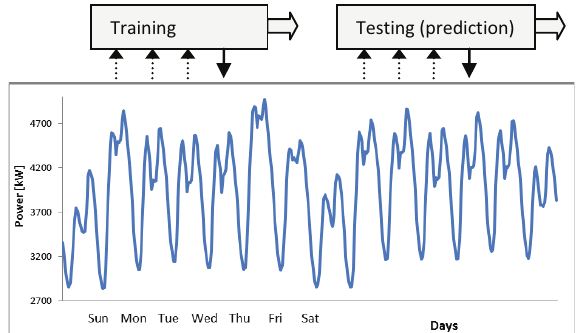
Fig. 1. Typical winter week cycles of the power demand (January) [A]